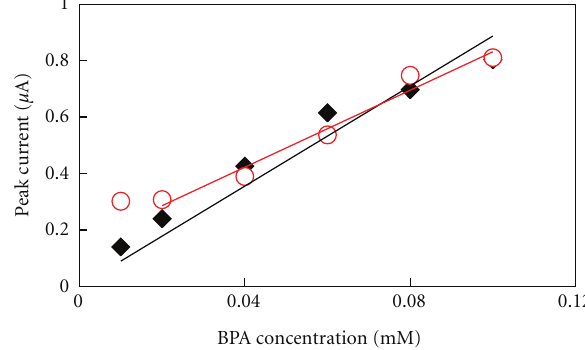
Figure 5: Calibration plot of bisphenol A. bu ff er, pH 7.0, (cid:4) in 60% (v/v) acetonitrile/0.1 M phosphate bu ff er, pH7.0. Scan rate